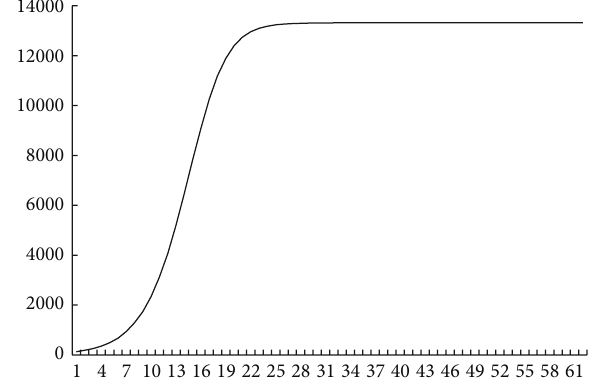
Figure 9: Plot of the diffusion of telephone users in rural area of China governed by model